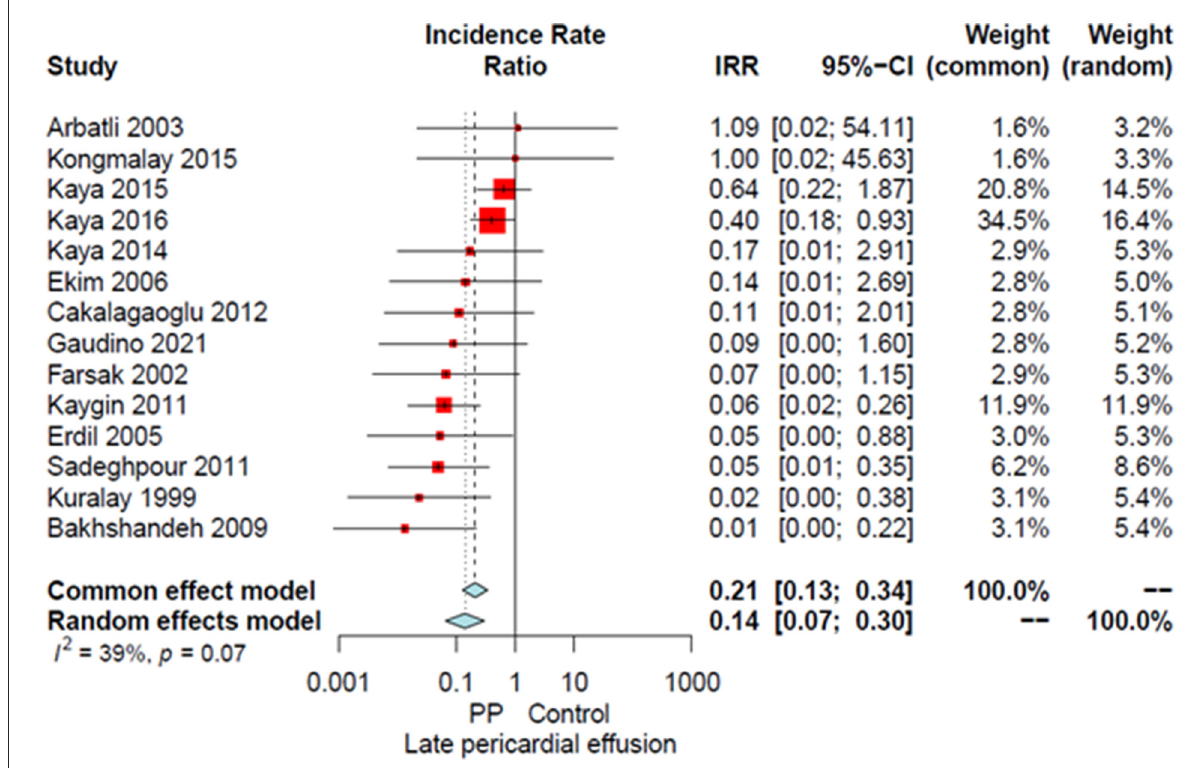
FIGURE3 Forest plot for late pericardial effusion. CI, confidence interval; IRR, incidence rate ratio; PP, posterior pericardiotomy.